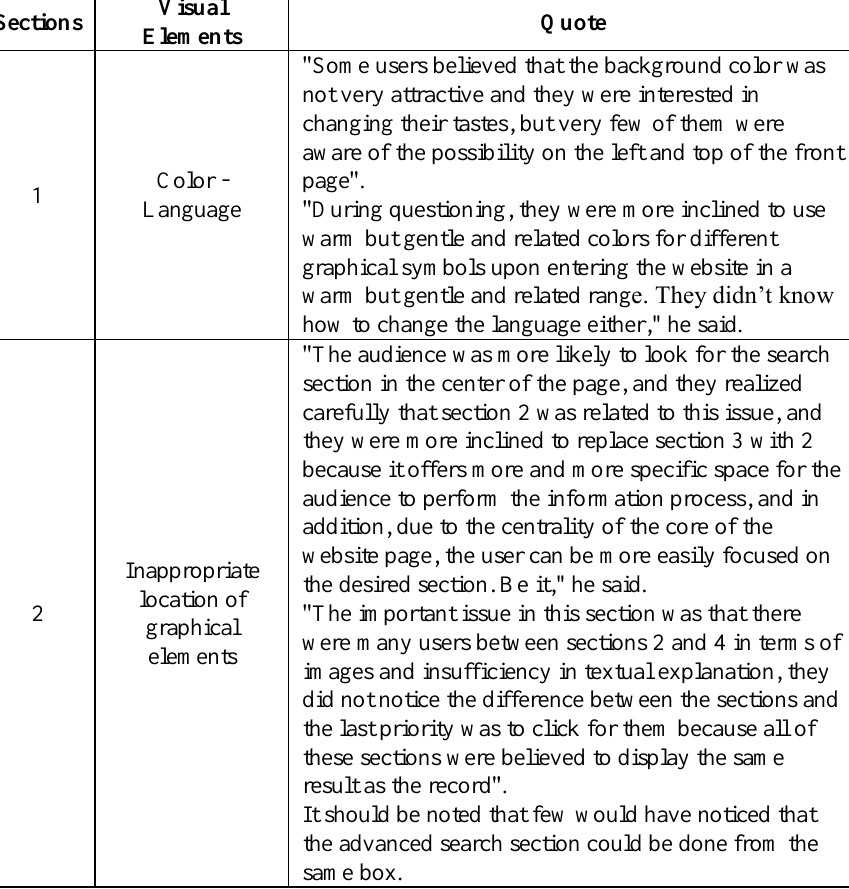
Table 3- Elements of user interest in the home